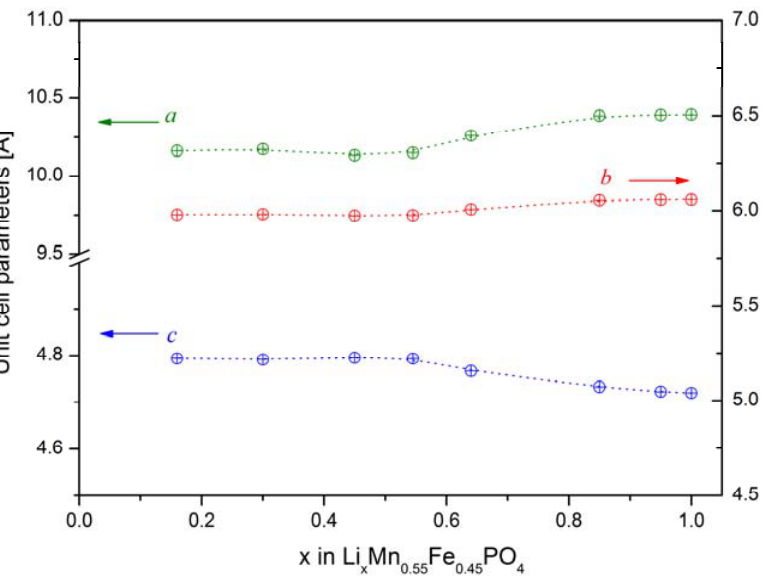
Figure 27. Unit cell parameters of electrochemically deintercalated Li function of lithium content. Data taken from